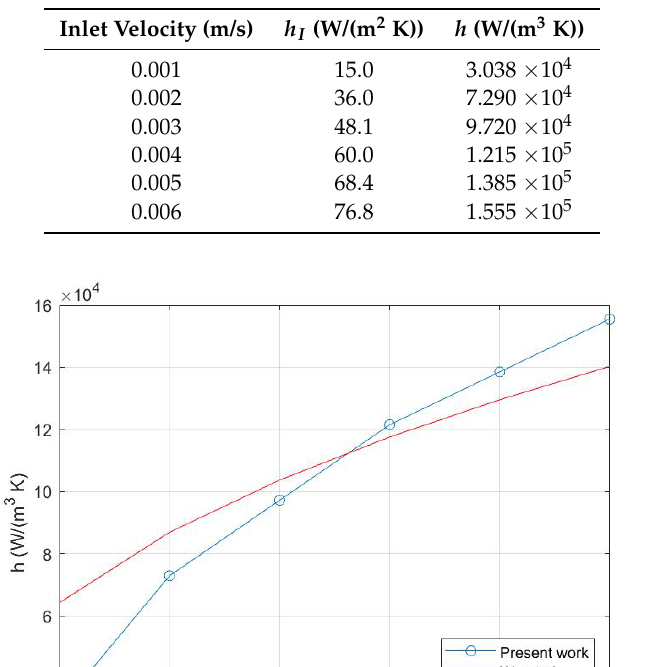
Table 1. Heat transfer coefficients.